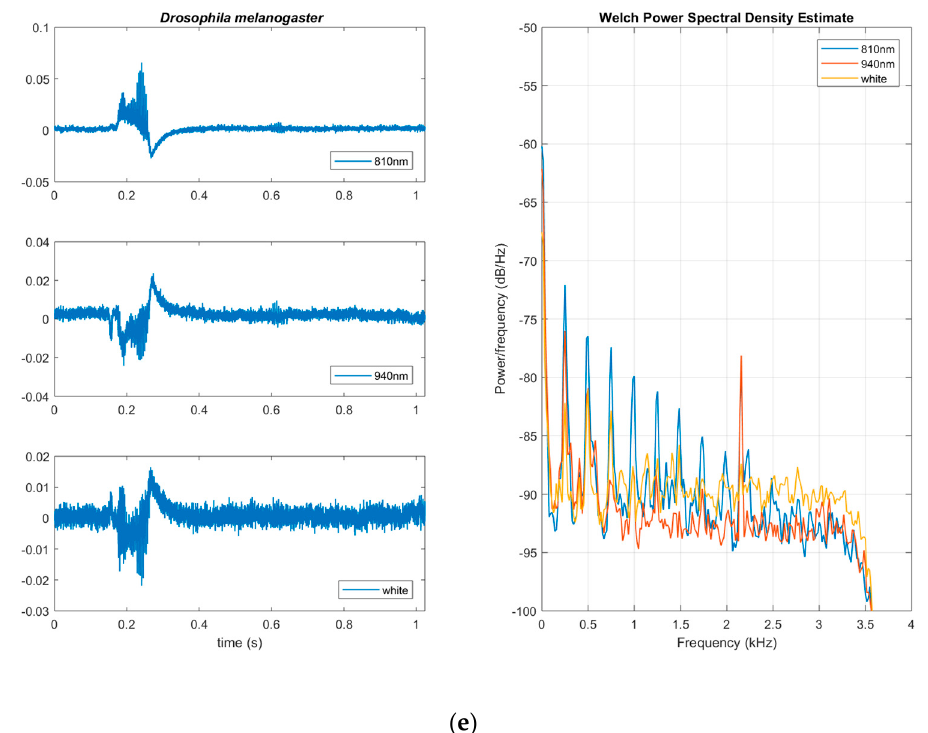
Figure 7. Optical wingbeat recording of backscattered light wings and main body using three different spectral bands (810 nm, 940 nm, white). Time domain signal at 8 kHz sampling rate for each band on the left column of each sub-figure and the Welch power spectral density on the right column. Recordings are treated as audio and the amplitude in y-axis is normalized between [ − 1, 1]. ( a ) The bee Apis mellifera , ( b ) the wasp Polistes gallicus , ( c) the fruit fly Zaprionus , ( d) the fruit fly Drosophila suzukii , and ( e ) the fruit fly Drosophila melanogaster .